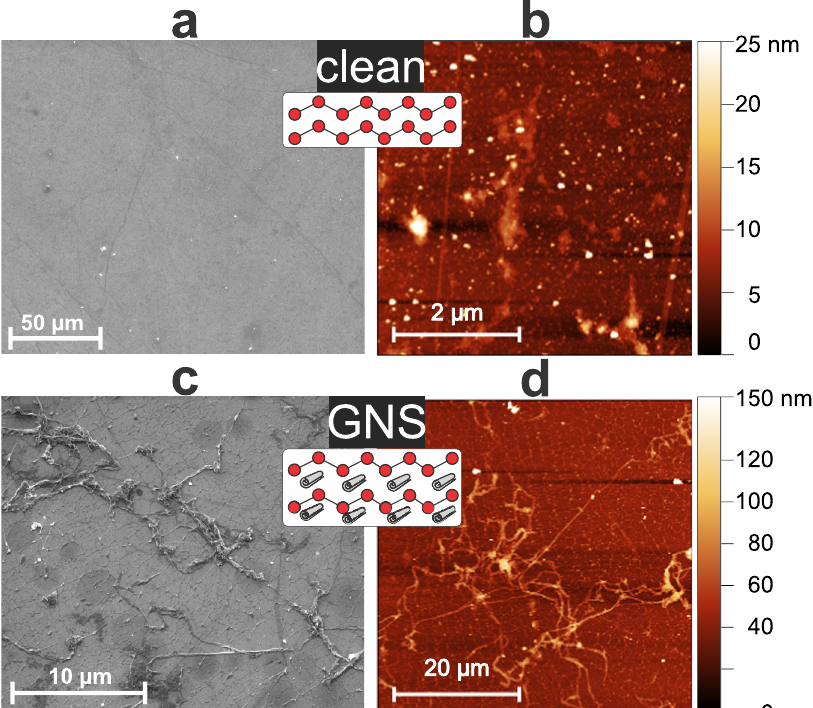
Fig. 2 Structural and topological characterization of the graphene nanoscrolls. a , b SEM and AFM images of the clean 2 L graphene. c , d SEM and AFM images of the 2 L graphene with